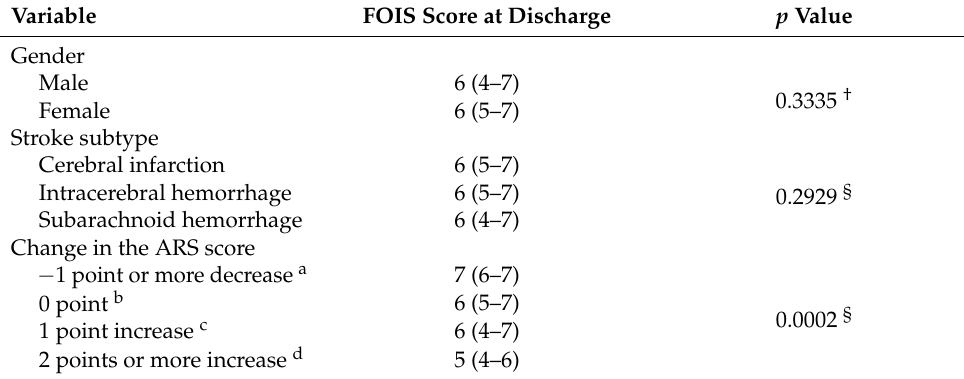
Table 4. Subgroup analysis of main outcome.